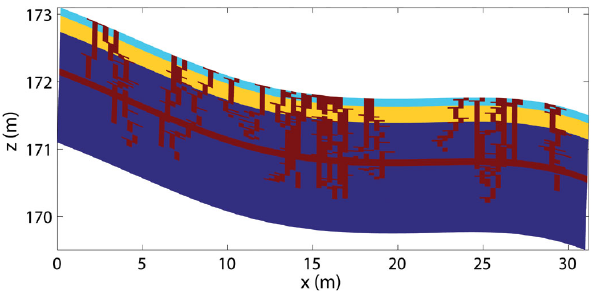
Fig. 2. One of the model setups. Hillslope with different soil layers and the effective macropore region as explicit structures